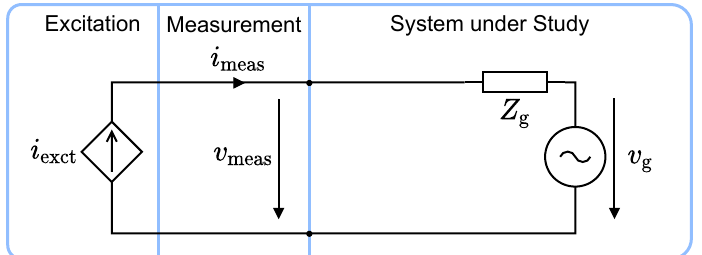
Figure 11. Ideal impedance measurement scenario in which the power grid is free of harmonics.